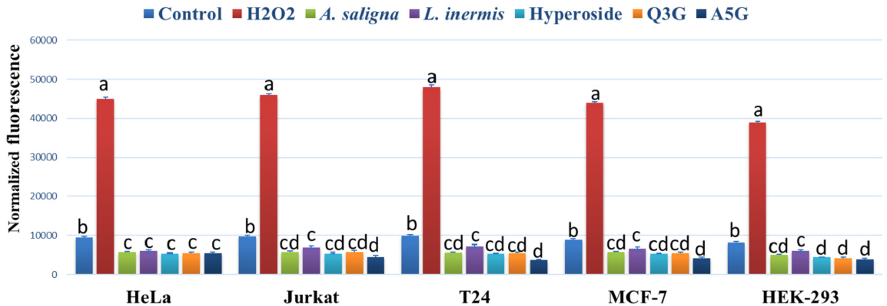
Figure 5. The effect of A. saligna and L. inermis methanolic extracts, hyperoside, quercetin 3-glucuronide (Q3G), and apigenin 5-glucoside (A5G) DPPH IC 50 on the 2 ′ ,7 ′ -dichlorofluorescein (DCF) fluorescence in HeLa, Jurkat, T24, MCF-7 and HEK-293 cells. A medium with 1 mM hydrogen peroxide (H 2 O 2 ) was used as a positive control. The data are expressed as the mean ± SD of three experiments (four replicates per treatment). Different letters among group of columns indicate significant differences ( p ≤ 0.05 ).